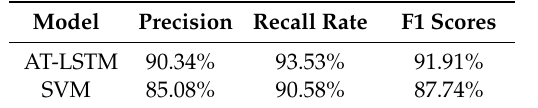
Table 15. Model performance